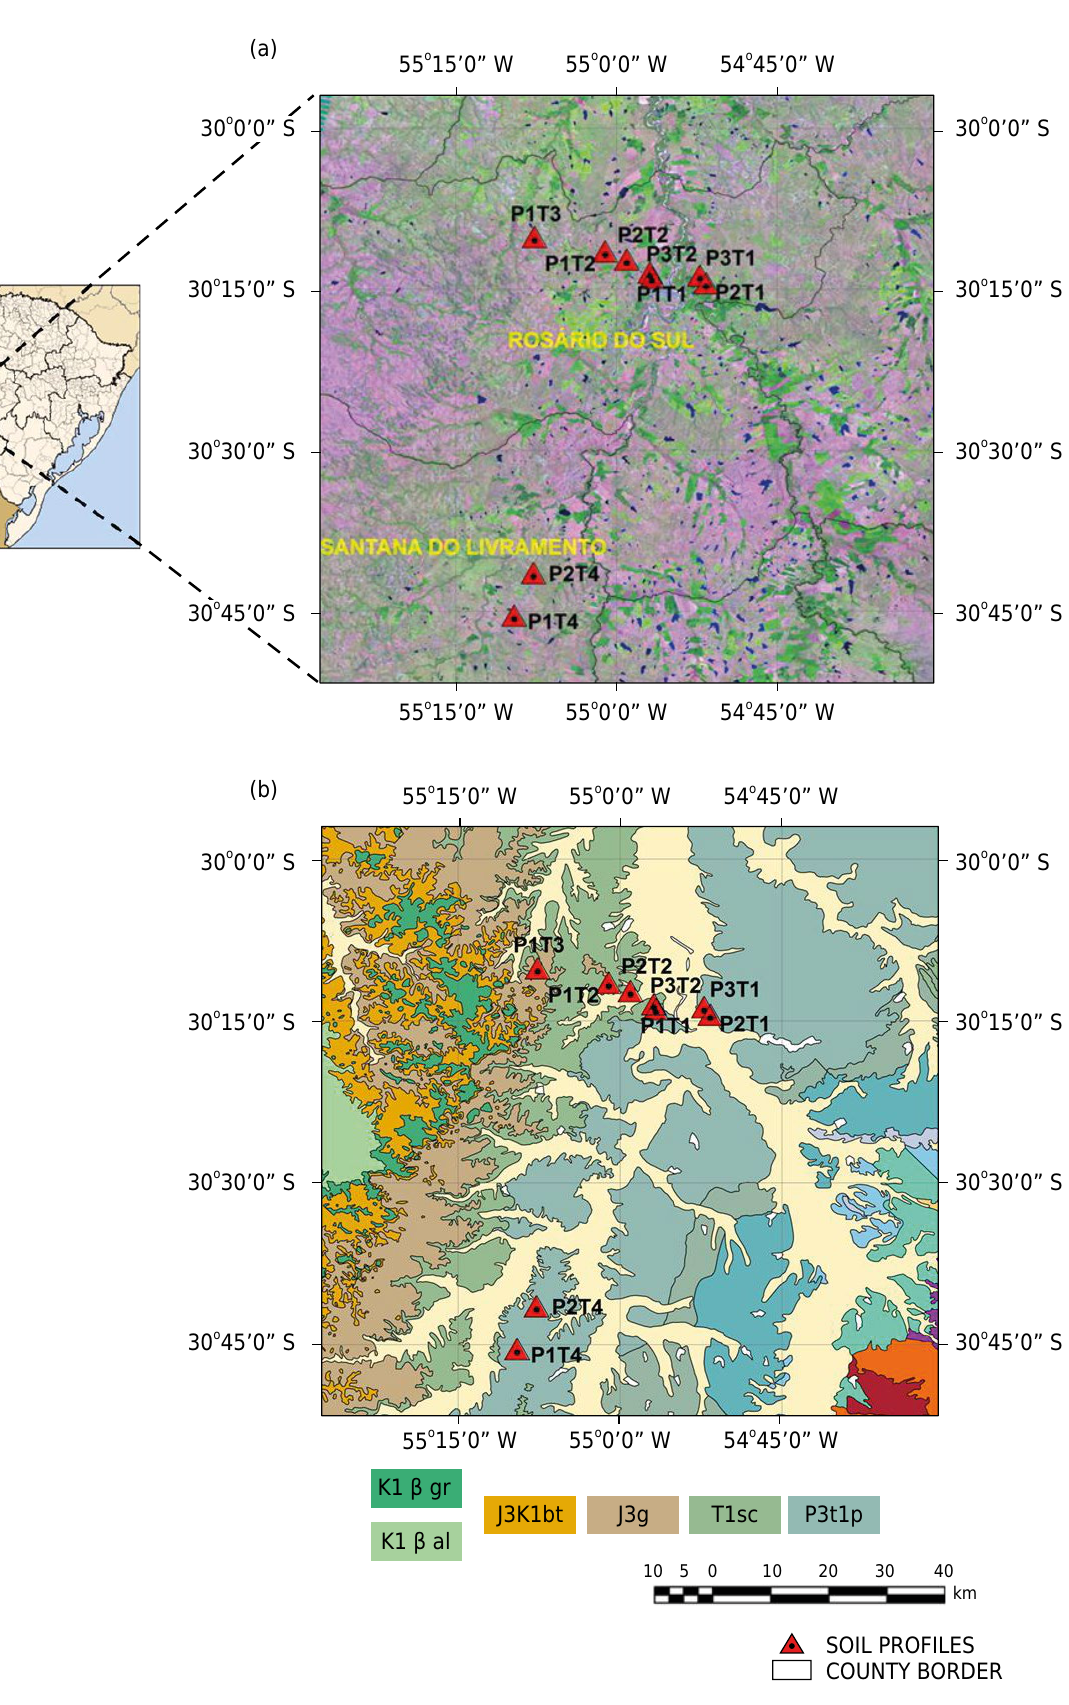
Figure 1. (a) Image chart with the geographical location of the study area and soil profiles - Municipality of Rosário do Sul and Santana do Livramento, RS (Image Landsat 5 Thematic Mapper - Composition 5R4G3B / Datum SAD69 - Scale indicated). (b) Simplified geological map of part of the southwest region of the state of Rio Grande do Sul. Main Formations - P3T1p: Pirambóia Formation; T1sc: Sanga-do-Cabral Formation; J3g: Guará Formation; J3K1bt: Botucatu Formation; K1β: Serra Geral Formation (Scale